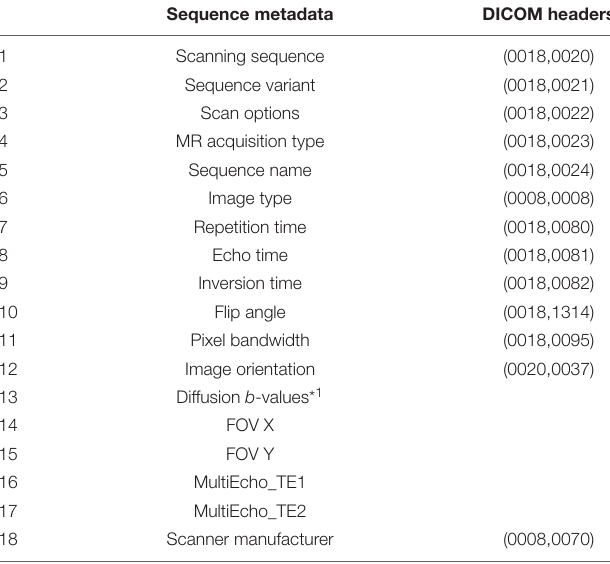
TABLE 3 | A list of the MRI sequence metadata used as features in the current machine learning